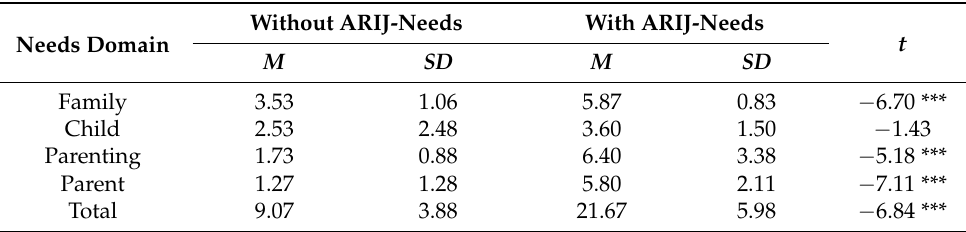
Table 1. Differences in Identified Dynamic Risk Factors Between Needs Assessment With and Without the Needs Assessment Instrument (ARIJ-Needs). Without ARIJ-Needs With ARIJ-Needs t Needs Domain M SD M SD Family 3.53 1.06 5.87 0.83 − 6.70 *** Child 2.53 2.48 3.60 1.50 − 1.43 Parenting 1.73 0.88 6.40 3.38 − 5.18 *** Parent 1.27 1.28 5.80 2.11 − 7.11 *** Total 9.07 3.88 21.67 5.98 − 6.84